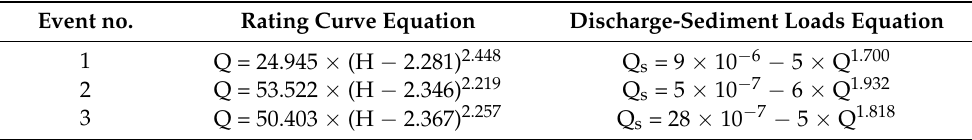
Table A1. Regression equations for flow and sediment discharge: H (water level); Q (river flow); Q s (sediment concentration). Event no.